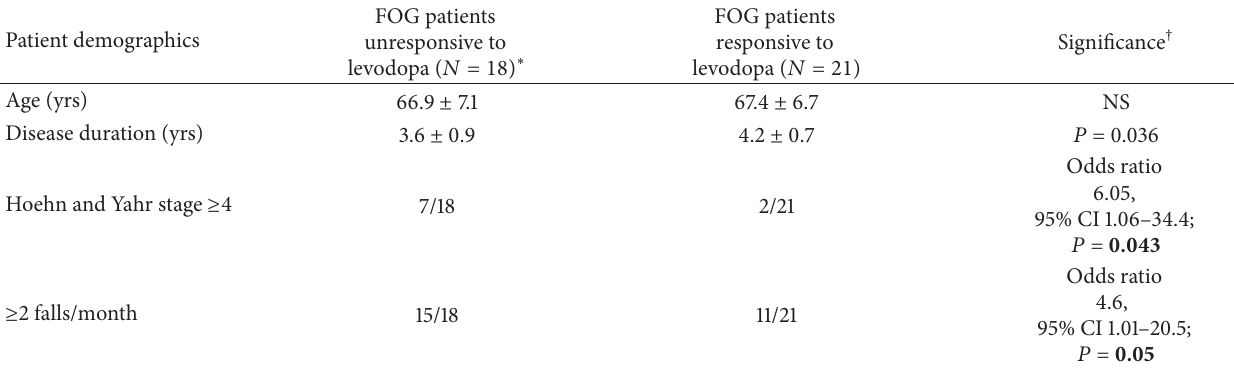
Table 1: Demographics of freezing of gait (FOG) patients unresponsive to levodopa compared to those of FOG patients responsive to levodopa.